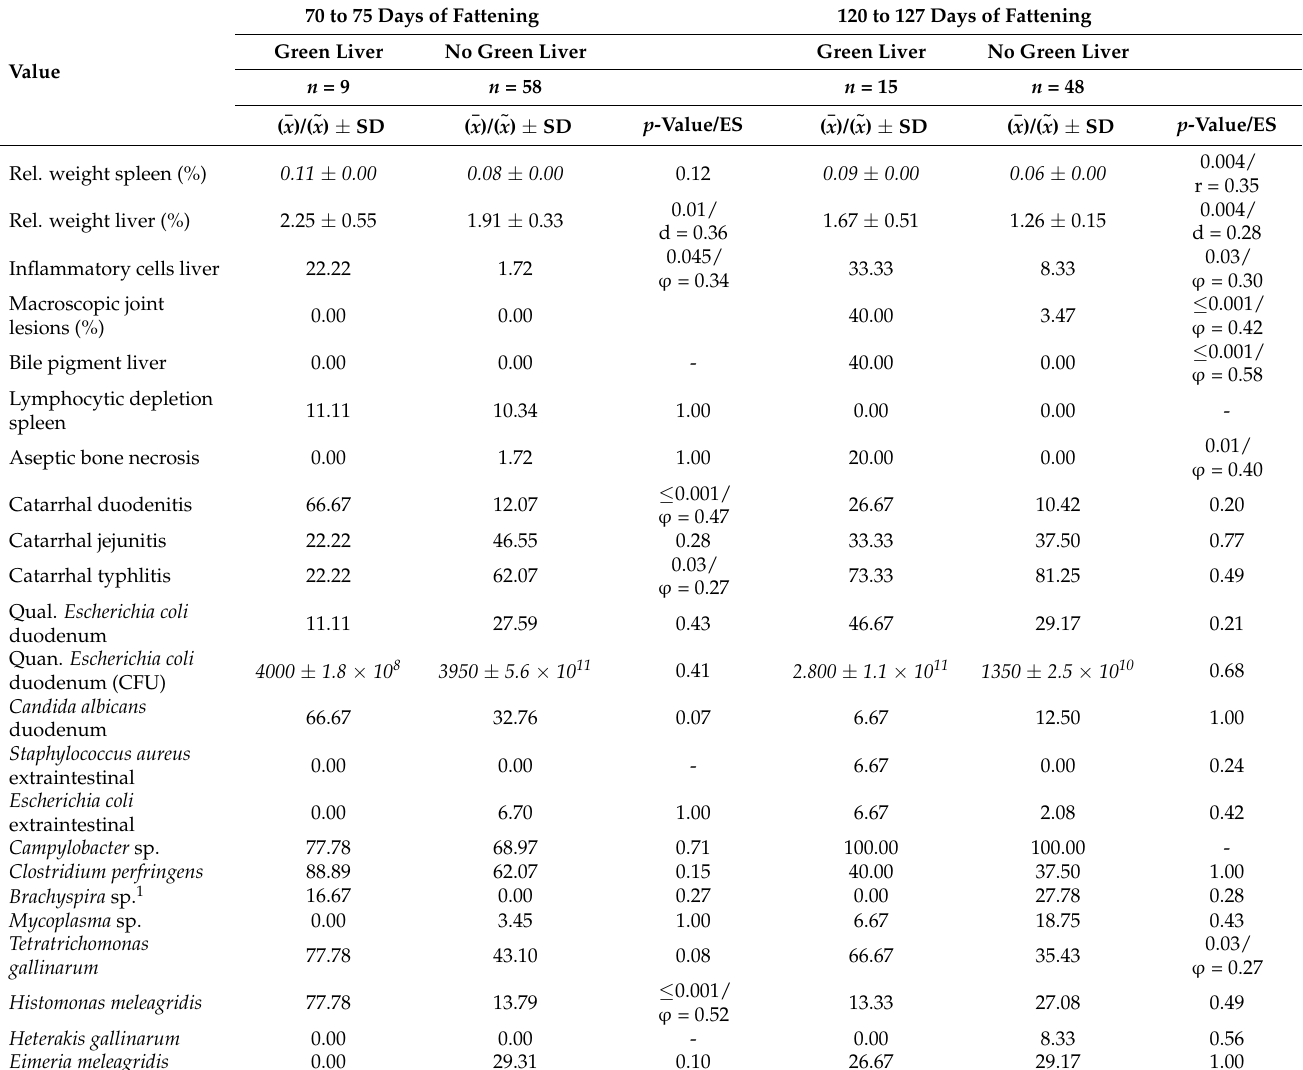
Table 2. Comparison of different values of the further examined 130 female Bronze turkey individuals with and without green liver discoloration in the early (70 to 75 days of fattening) and late (120 to 127 days of fattening) fattening stages, respectively. The presented data includes means ( x ), medians ( (cid:101) x ), standard deviations (SD), p -values, and (if applicable) effect sizes (ES) within the same age